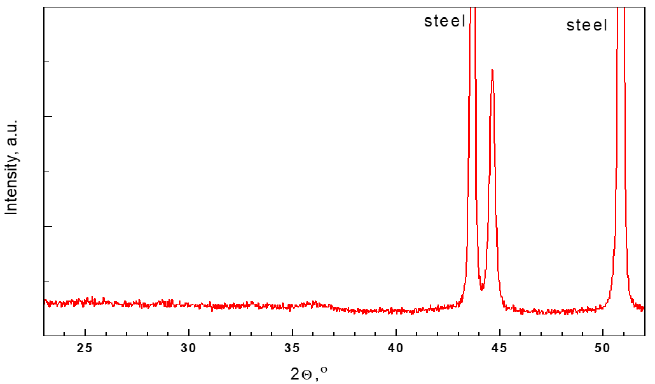
Figure 4. Typical XRD spectrum of freshly prepared ZrO 2 –TiO 2 coating, treated at 500 °C (sample A5).